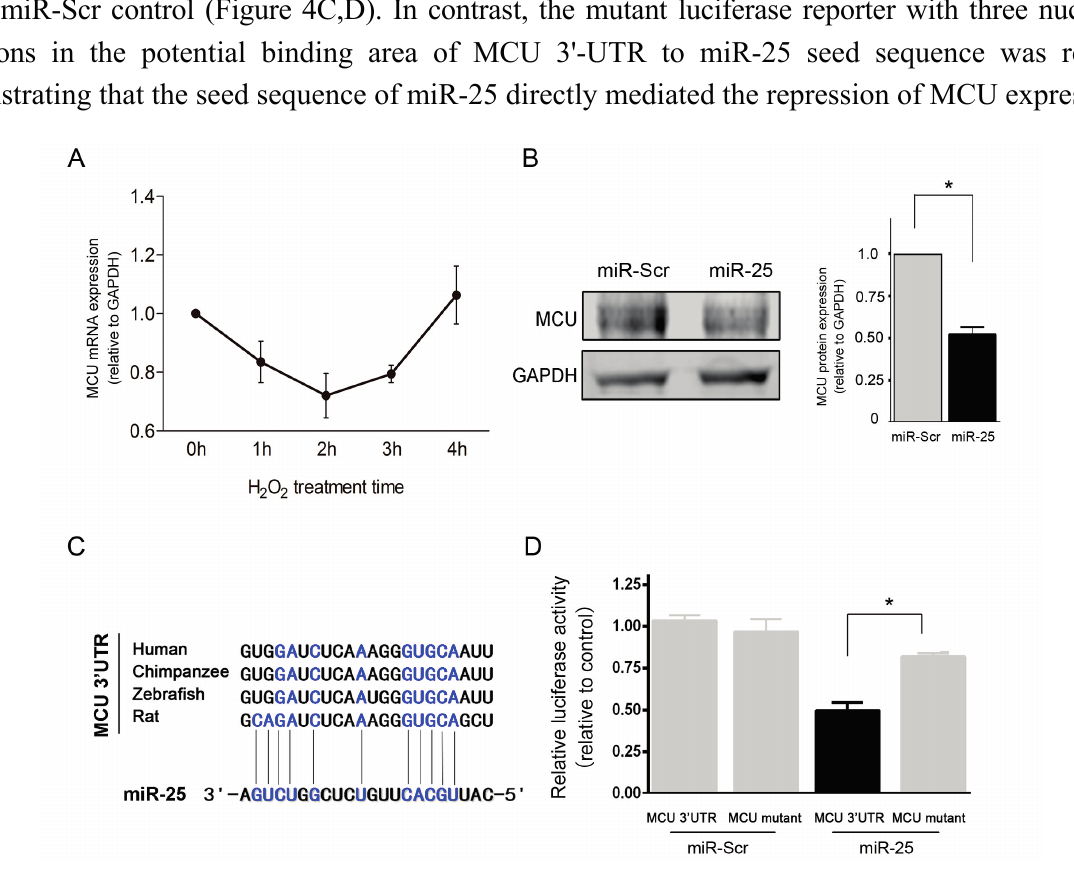
Figure 4. MCU is directly targeted by miR-25. ( A ) The time-course changes in the expression of MCU mRNA in response to H 2 O 2 exposure; ( B ) Western blot analysis of MCU in H9c2 cells overexpressing miR-25 or scramble control sequence (miR-Scr); ( C ) The potential binding site between miR-25 and the 3'-UTR of MCU mRNA. The complementary nucleotides are indicated by bolded blue letters; ( D ) The luciferase assay was performed using reporter plasmids harboring the wild-type and mutant MCU 3'-UTR. MiR-25 significantly inhibited the luciferase activity of the wild-type reporter, but not that of the mutant reporter. * p <